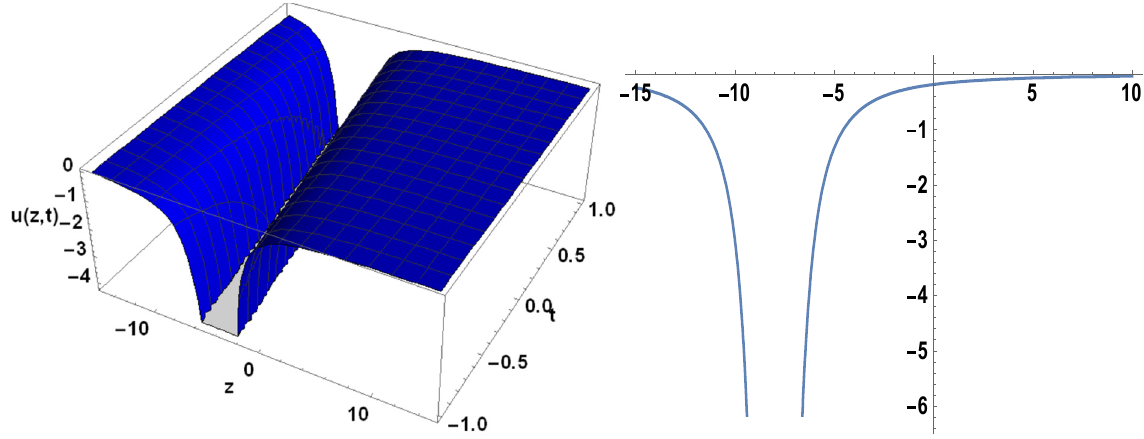
Figure 7. The 3D and 2D plots of Equation (57) for various values of parameters.